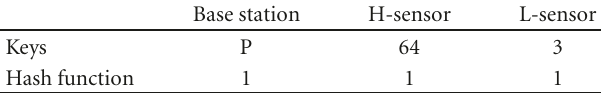
Figure 6: The comparisons of number of keys stored in the L- sensor. Table 3: The number of keys and functions stored in each member of